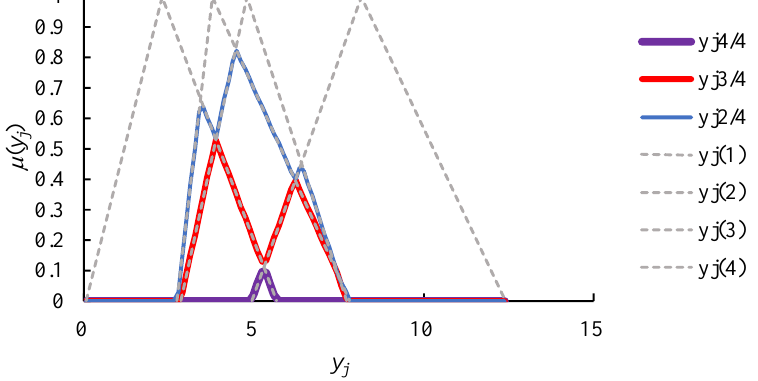
Figure 4. Typical EPCFI diagram.